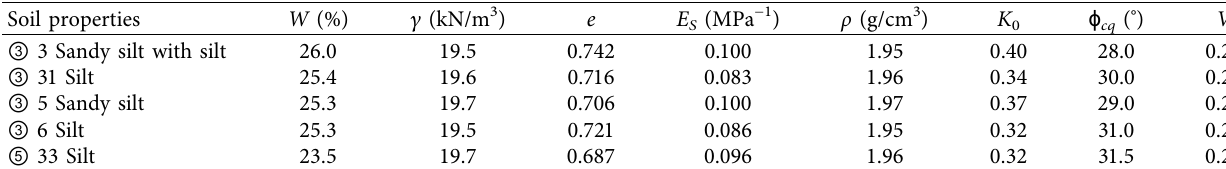
Table 1: Parameters of soils.